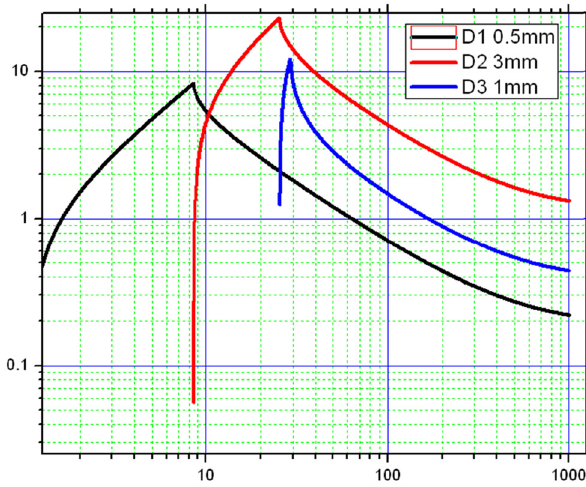
Figure 1: Simulation curve of high - energy proton energy loss.